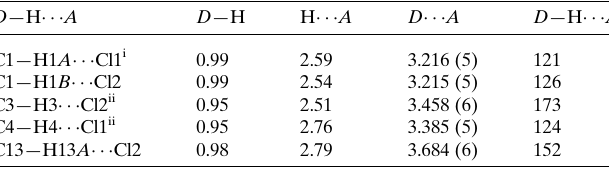
Table 1 Hydrogen-bond geometry (A˚ , (cid:3) ).